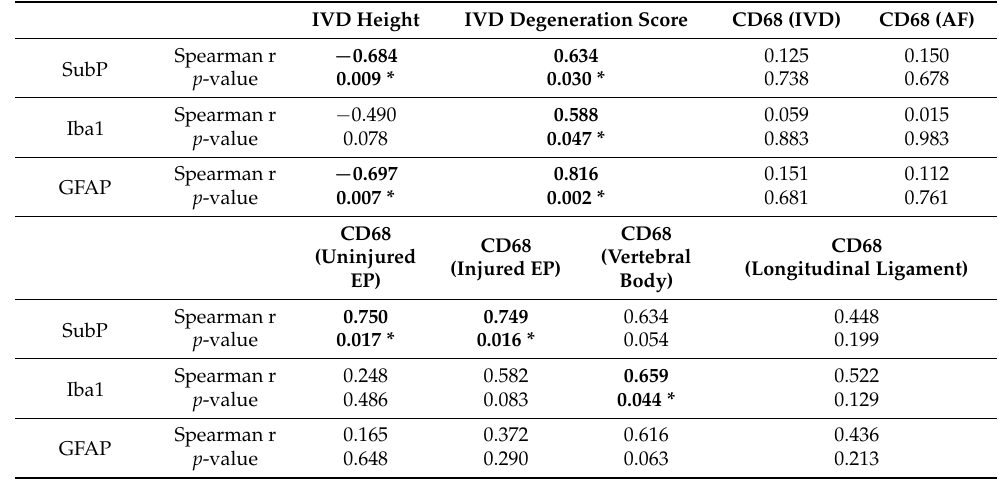
Table 3. Correlation analysis to identify important factors contributing to spinal cord